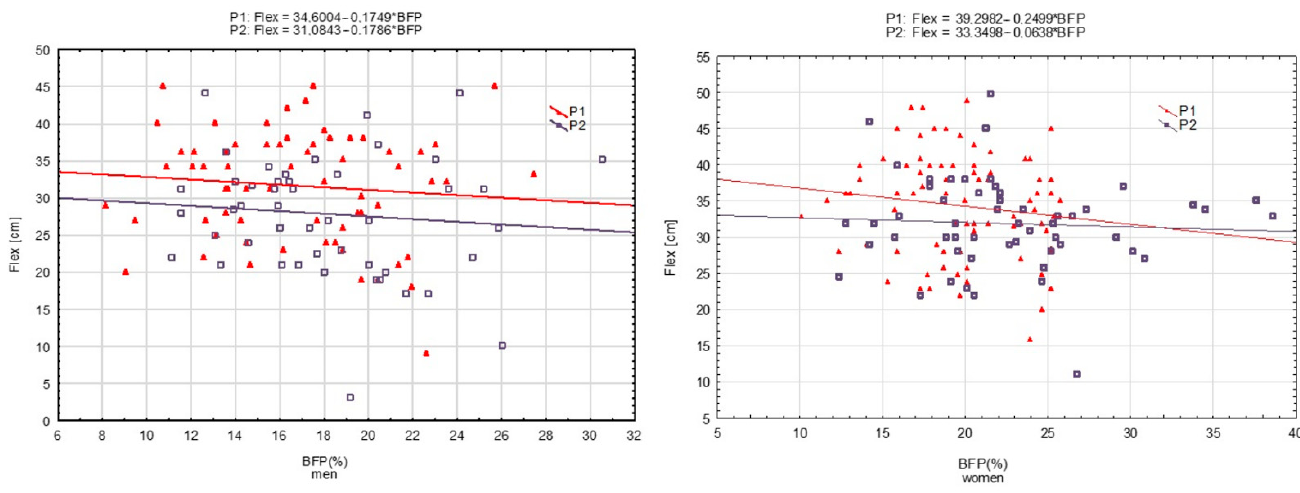
Figure 4. Flexibility (Flex) measured in 2001 (P 1 ) and 2022 (P 2 ) regressed on body fat percentage (BFP)—men and women, respectively.